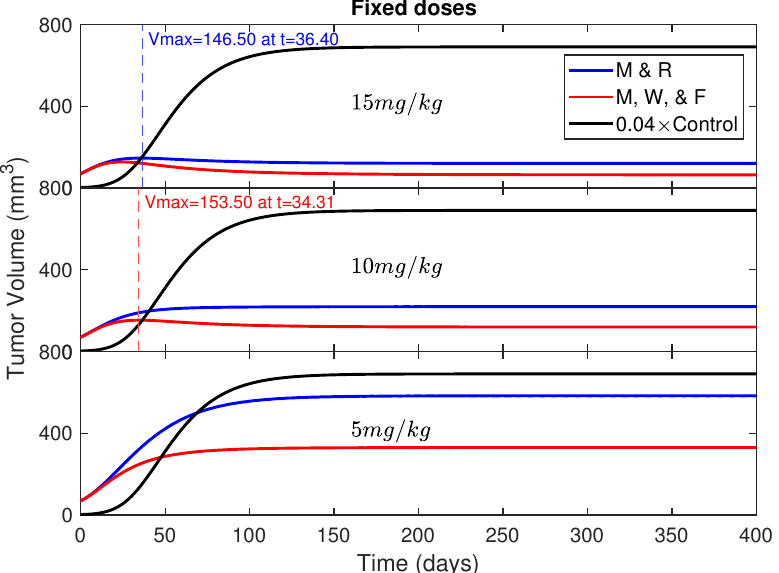
Figure 1. Comparison of three different doses versus control. These doses are given every Monday and Thursday or Monday, Wednesday, and Friday, with the first dose, starting from the day (counted as Day 1) after surgery. The maximum tumor volume V ( t ) associated with a 10 mg/kg dose offered every Monday, Wednesday, and Friday was found to be almost identical to the value associated with a 15 mg/kg dose given every Monday and